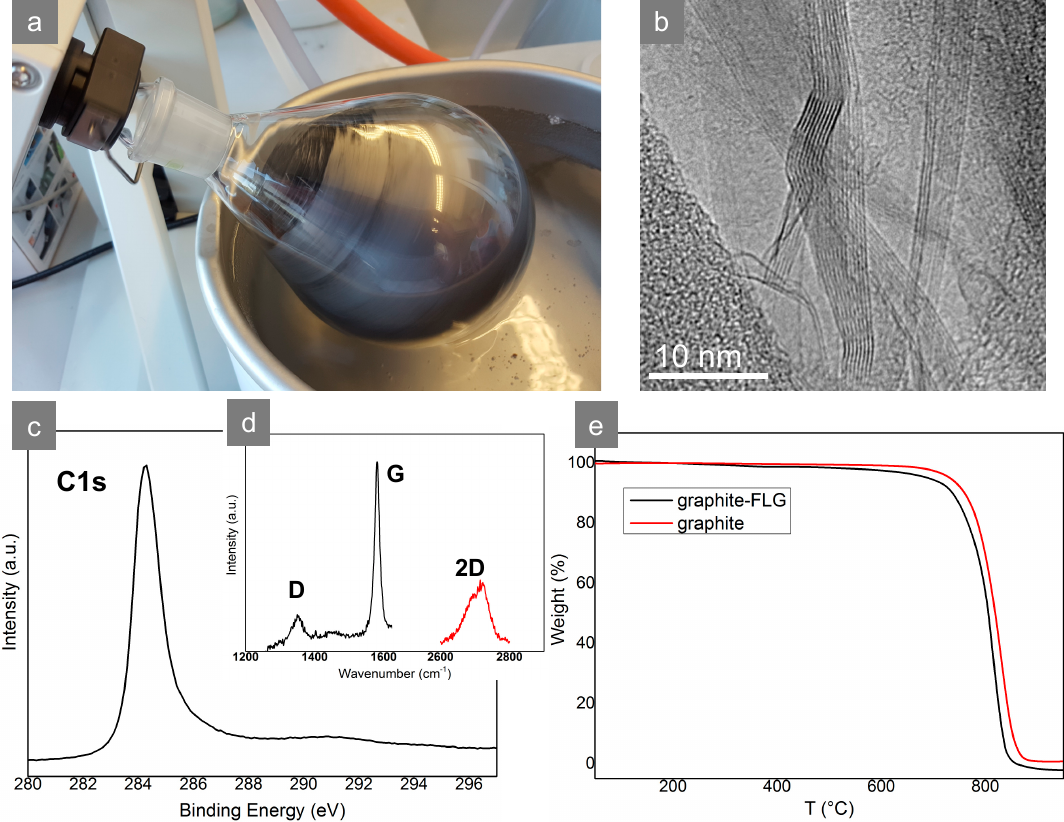
Figure 3. ( a ) Removal of the solvent from the FLG suspension by rotary evaporation, ( b ) TEM micrograph of graphite-FLG embedded into a polymer (PTF) showing different number of edges/sheets in particular FLG flakes (3–9 sheets), ( c ) C1s XPS spectrum of graphite-FLG, ( d ) Raman spectrum of graphite-FLG, and ( e ) TGA curves of graphite and graphite-FLG.